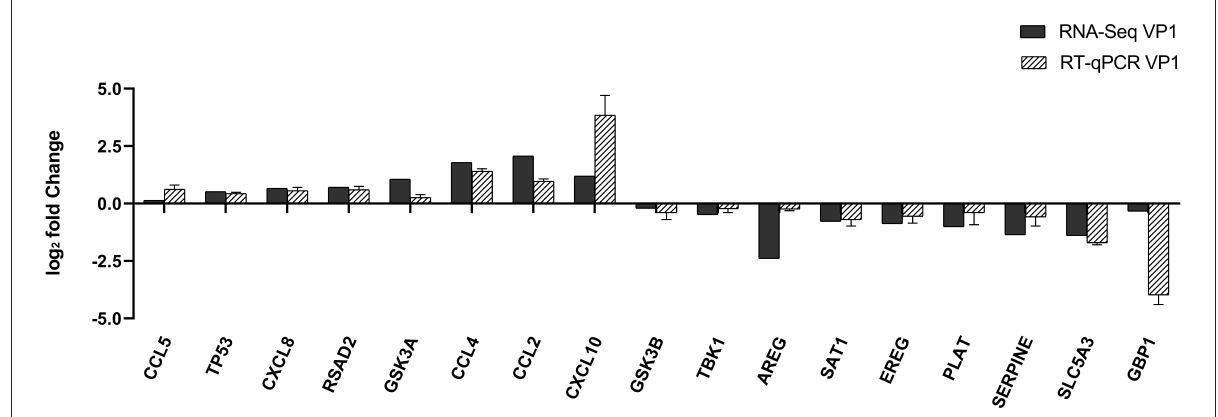
FIGURE4 Comparison of fold changes of DEGs between RNA-Seq and qRT-PCR. PK-15 cells were transfected with pCAGGS-HA and pCAGGS-HA-VP1 for 36h, then qRT-PCR was performed to detect the relative expression of selected DEGs. The horizontal axe represents the name and the vertical axe indicates log2-fold changes of